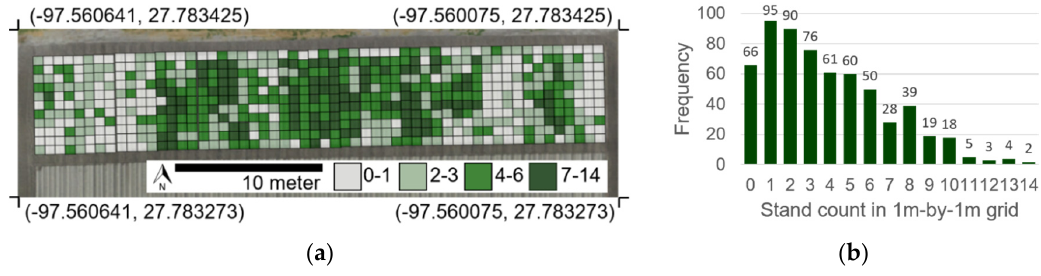
Figure 1. Plant count of the entire study area at the grid level (1 m 2 ) ( a ) and its histogram ( b ). Plant count assessed by visual inspection of Unmanned Aircraft Systems (UAS)-derived orthomosaic image.